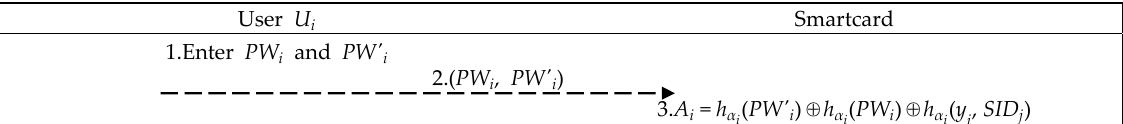
Figure 5. Offline password change phase of the proposed scheme.